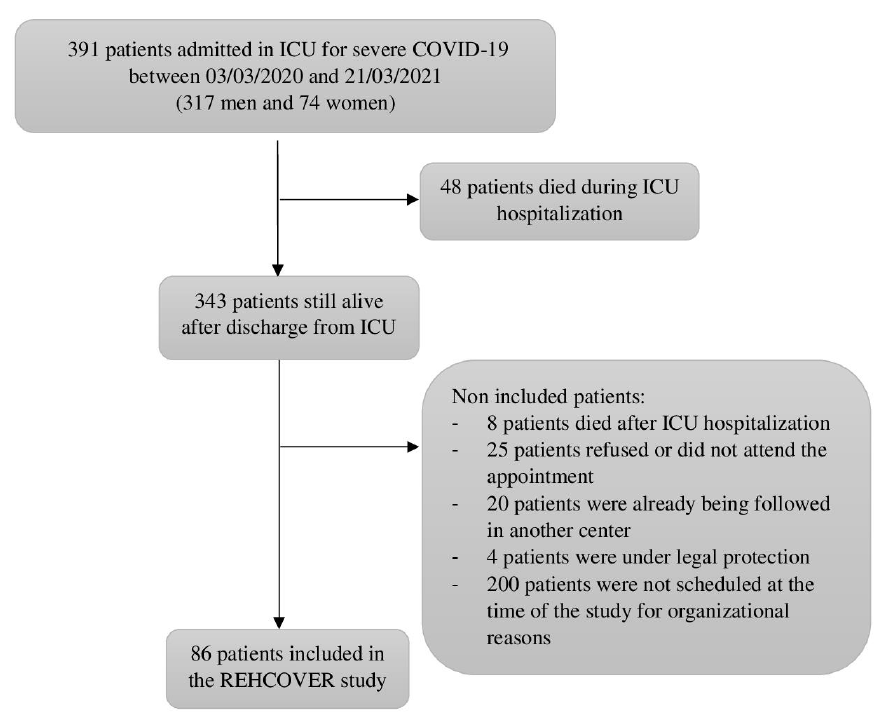
Figure 1. Study design. Abbreviations: ICU: intensive care unit; COVID-19: Coronavirus Disease-19. Table 1. Baseline and hospitalization characteristics of the patients. Patients’ characteristics at baseline and during hospitalization are summarized in Ta- ble 1. Obesity (BMI > 30 kg/m 2 ), hypertension, diabetes, and dyslipidemia were the most Demographic Characteristics and common pre-existing comorbidities with a frequency of 50%, 46.5%, 34.9%, and 39.5%, respectively. Twelve patients (14.0%) had an underlying, already diagnosed pulmonary disease (including seven patients with chronic obstructive pulmonary disease [COPD], two patients with emphysema, one patient with asthma, one patient with bronchiolitis